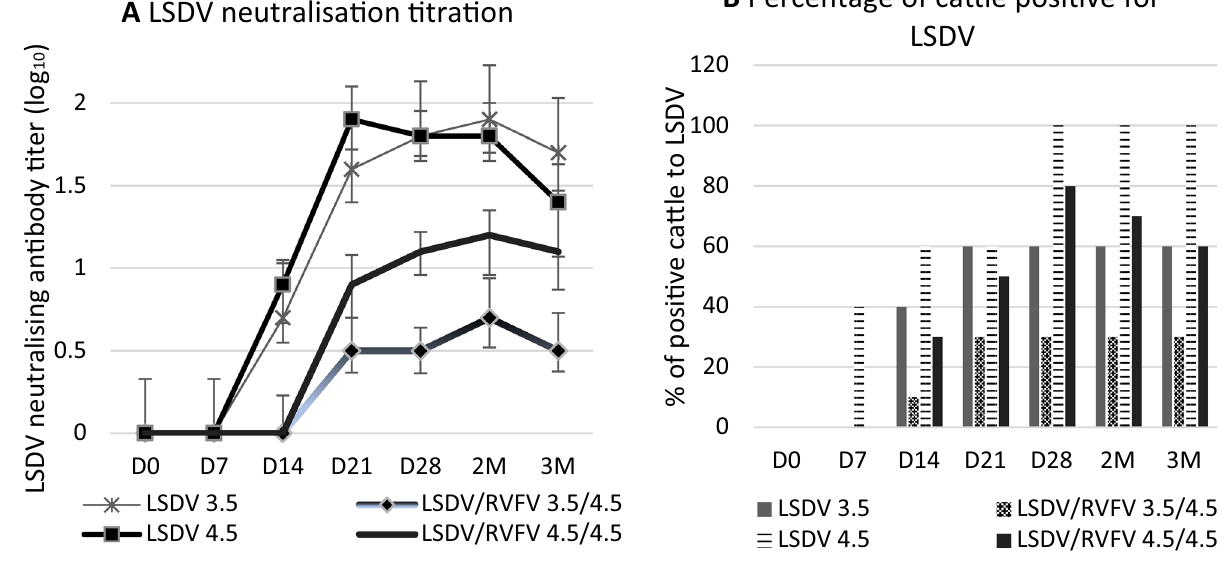
Figure 8. Antibody titers response in cattle vaccinated with LSDV and with combined LSDV/RVFV monitored from D0 to 3 months pv. ( A ) LSDV neutralization antibody titers in log 10 . Data shown are means of at least three neutralization experiments. ( B ) Percentage of cattle positive for LSDV injected with two different doses for LSDV (10 3.5 and 10 4.5 TCID 50 /dose) and RVFV (10 3.5 and 10 4.5 TCID 50 /dose). D: Days M: Months.